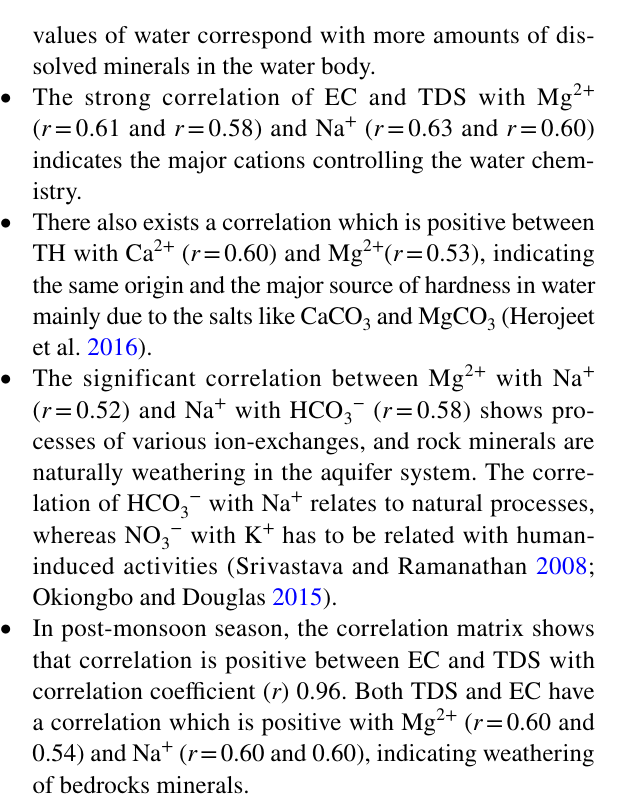
The highlighted or bold ones are those which are above 0.5 which have some correlation level and rest below 0.5 which have very low or negligi- ble correlations are